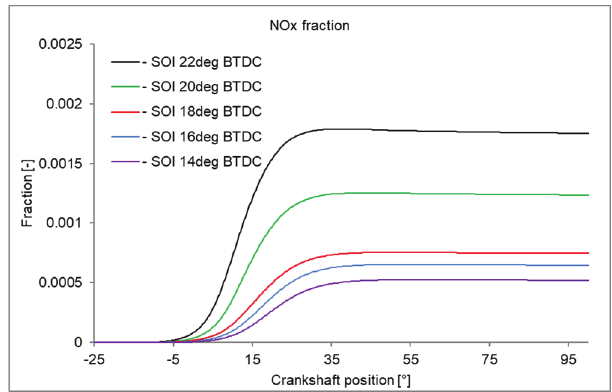
Fig. 8. Nitric oxides fraction in the combustion